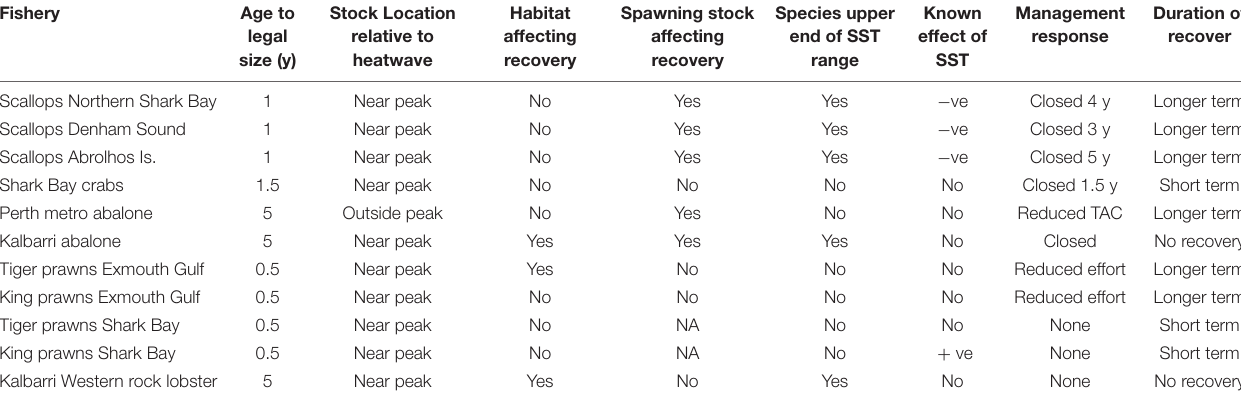
TABLE 1 | The effect of the marine heatwave (MHW) on the recruitment and the level of recovery after the heatwave are compared to the mean abundance indices in the 5 years before the heatwave. Fishery